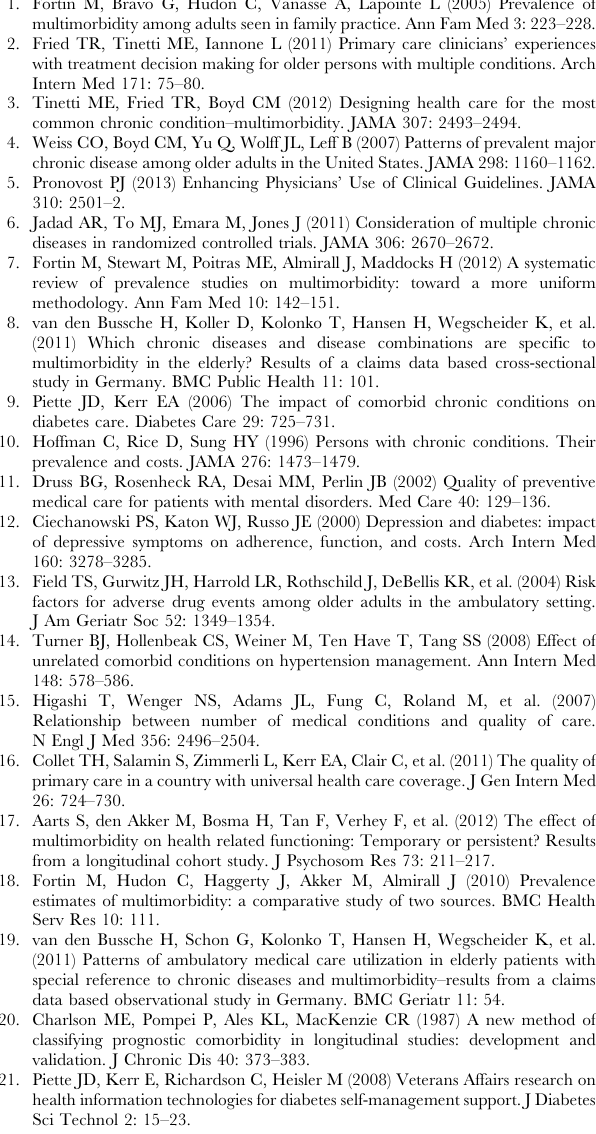
Table S3 List of 17 selected comorbidities in ambula- tory